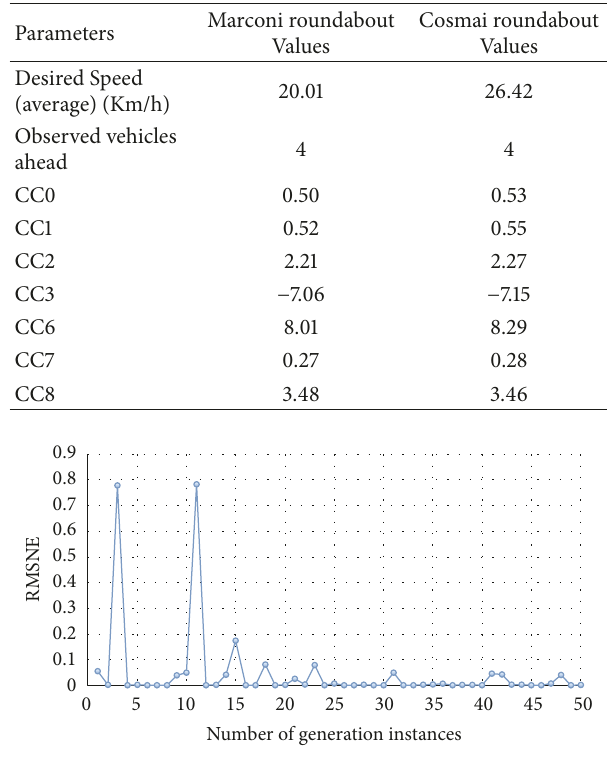
Figure 4: Values of the RMSNE during the optimization process for the Marconi